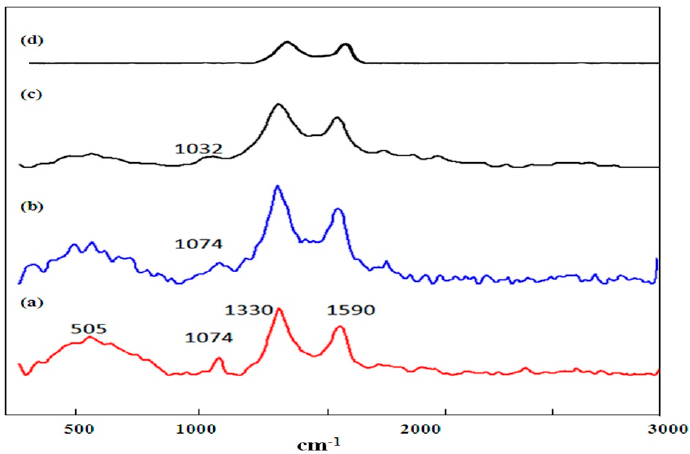
Figure 4. Raman spectra of: ( a ) Zn-Al-GO1, ( b ) Zn-Al-GO2, ( c ) Zn-Al-GO3 and ( d ) the prepared graphene.